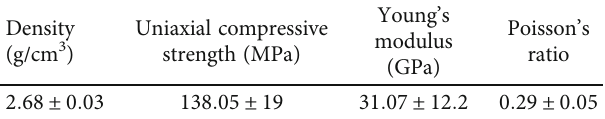
Table 2: Mechanical parameters of granite